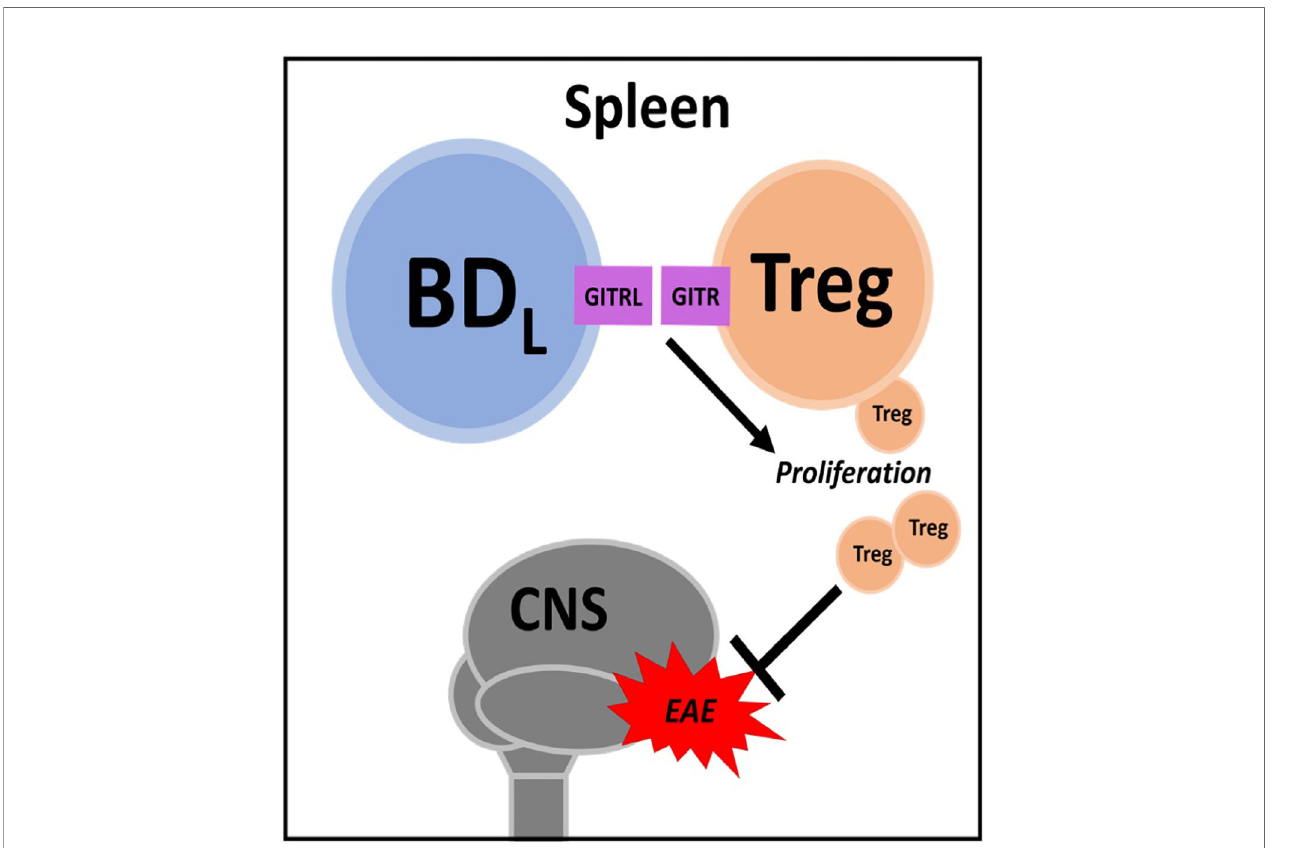
FIGURE 2 | BD L . In the spleen BD L promote regulatory T cell (Treg) proliferation through GITR-GITRL interactions. Treg attenuate experimental autoimmune encephalomyelitis (EAE)